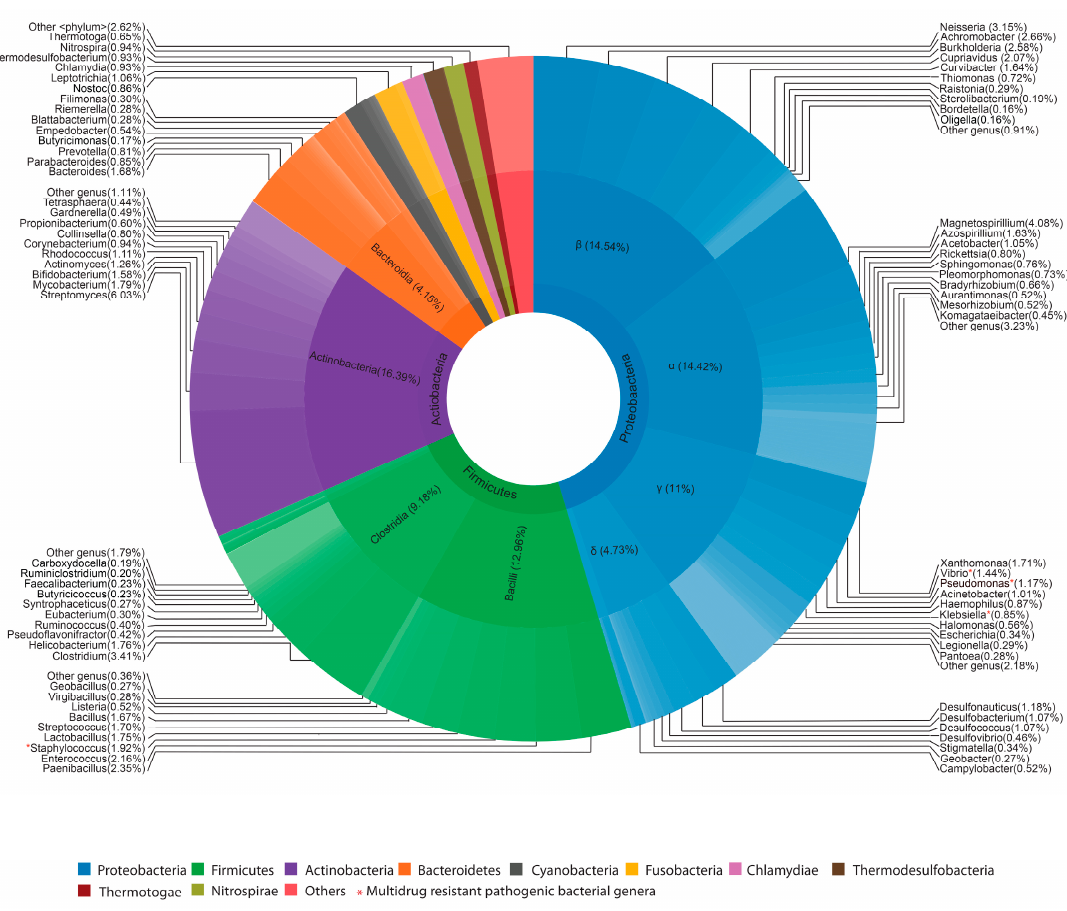
Figure 1. Bacterial taxonomic distribution of flooded sites. Sunburst plot showing the taxonomic classification and relative abundance of bacterial species in flooded sites. The taxonomic phylum is represented in the innermost ring, class in the middle, and genus are represented in the outermost ring of the circle. Within each taxonomic classification, taxa are sorted according to its abundance. A red * symbol represents the multidrug-resistant pathogenic bacteria present in flooded sites. See Table S1 for the full list of bacterial taxa found in flooded sites.